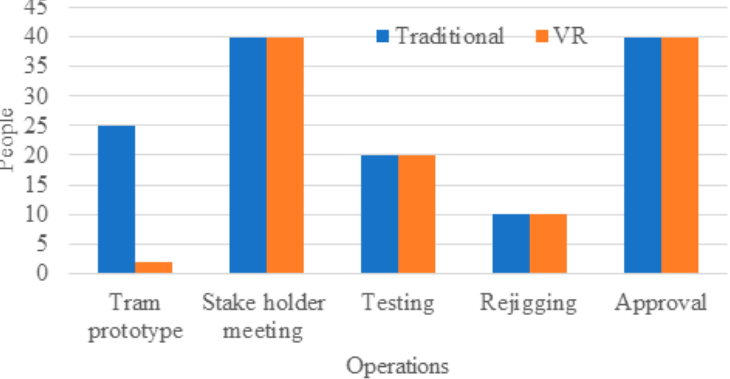
Figure 8. People’s involvement in traditional versus Metaverse-based studies.